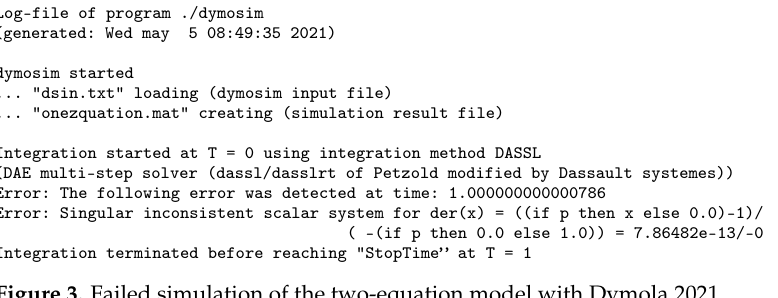
Figure 3. Failed simulation of the two-equation model with Dymola 2021.